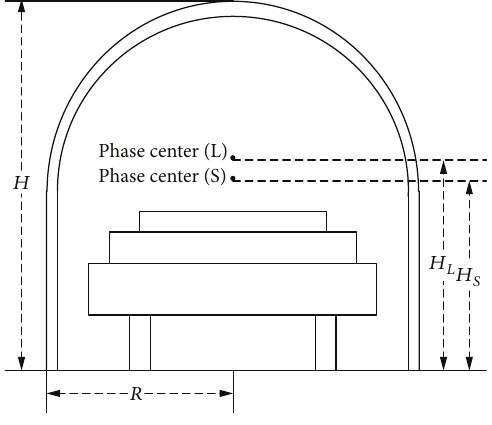
Figure 1: Antenna-radome system